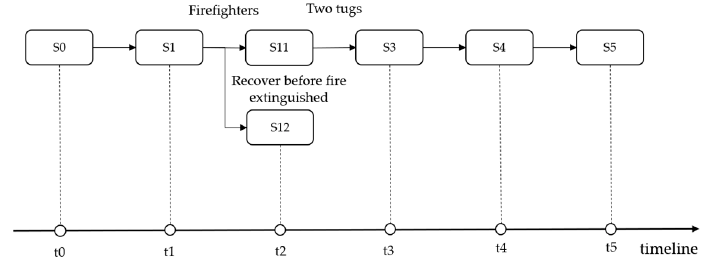
Figure 8. The Expansion of the ATLANTIC EMPRESS scenario instances chain.